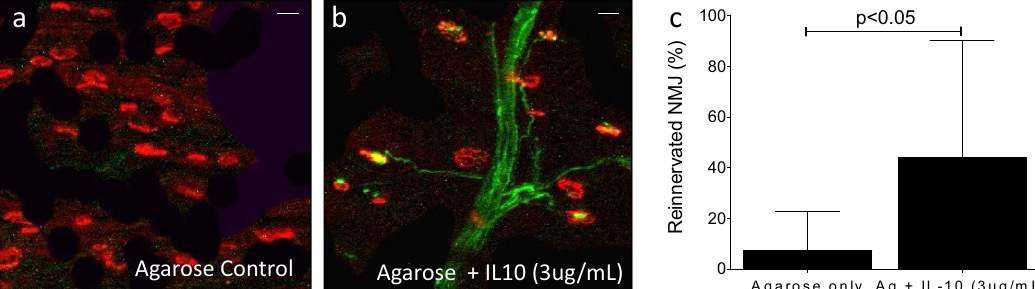
Fig. 10 Immunomodulation promotes neuromuscular junction formation 8 weeks after injury. EDL muscle of GFP rats 8 weeks after sciatic conduit repair with exogenous IL10 (3 µg/mL) shows the increased formation of neuromuscular junctions (NMJ, P < 0.05). Representative images of terminal axons (green) innervating postsynaptic Acetylcholine receptors labeled with rhodamine- ɑ -bungarotoxin (red) conjugated to Alexa Fluor-594 in control ( a ) and treated groups ( b ). The proportion of innervated NMJ standardized to contralateral control indicates a signi fi cant increase in NMJ formation with exogenous IL10 ( c , P = 0.049, two-tailed t test, n = 8 per group, 4 male, 4